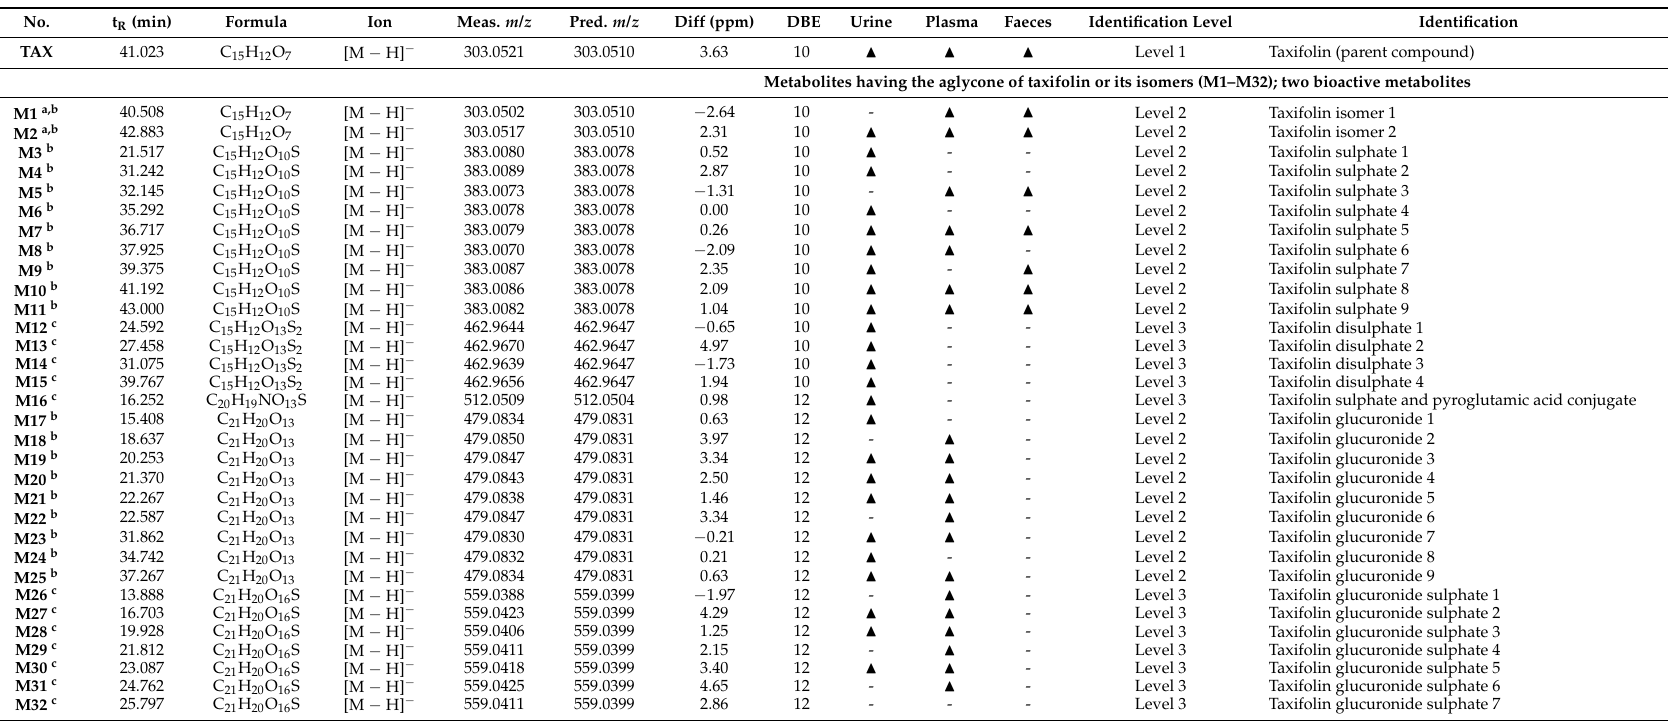
Table 1. Retention time (t R ), HRMS data, molecular formula, and identification of taxifolin and its 191 metabolites in rats urine, plasma, faeces by HPLC-ESI-IT-TOF-MS n